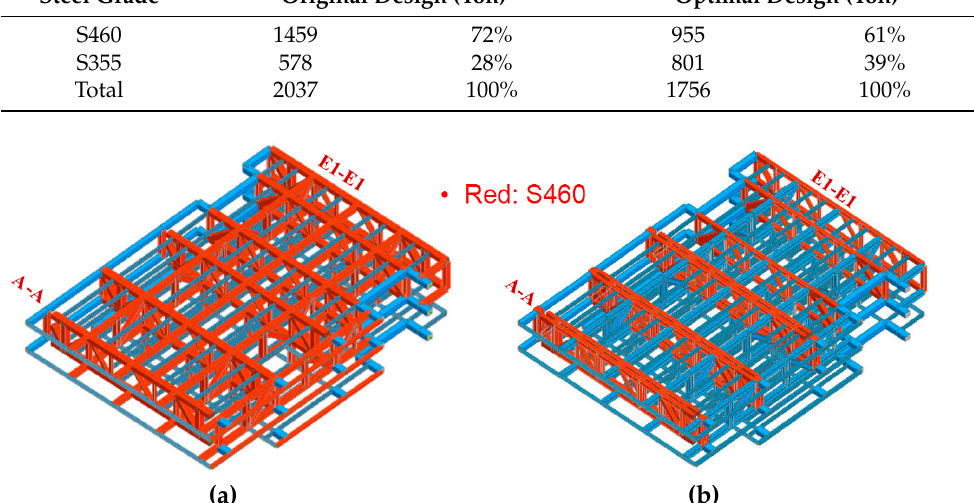
Figure 5. Distribution of high-grade steel S460. ( a ) Original design; ( b ) Optimal